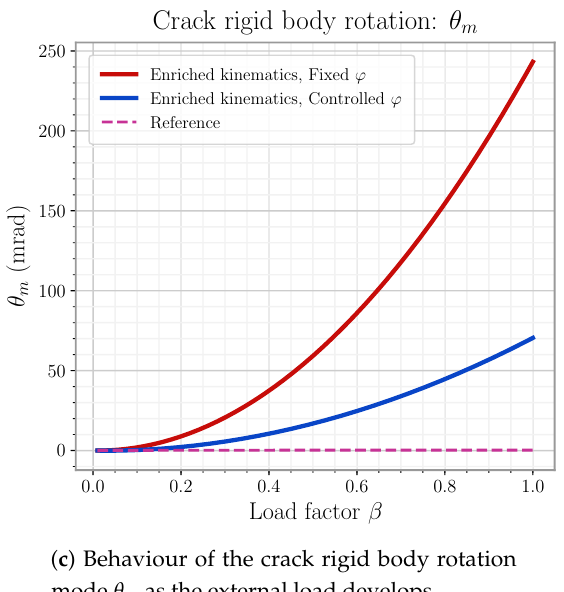
Figure 18. Comparison of the response of fracture rigid body rotations for the enriched modes formulations, having ( a ) rigid body rotation θ n , ( b ) rotation θ t and ( c ) rotation θ m . The other formulations do not count with such kinematic